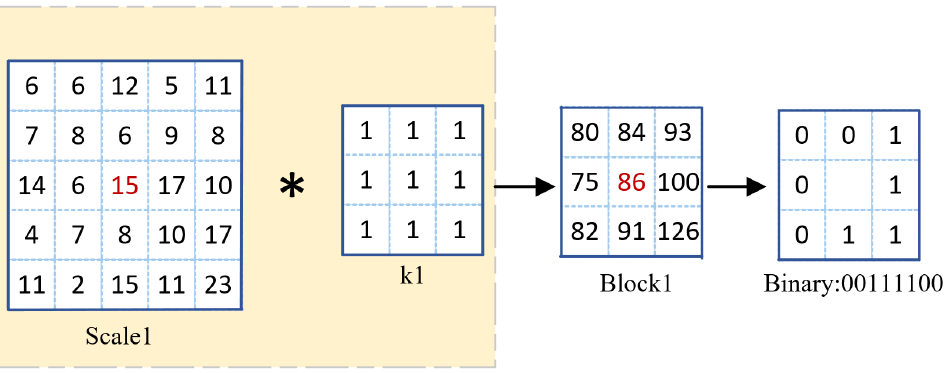
Figure 6. Multi-scale LBP feature extraction